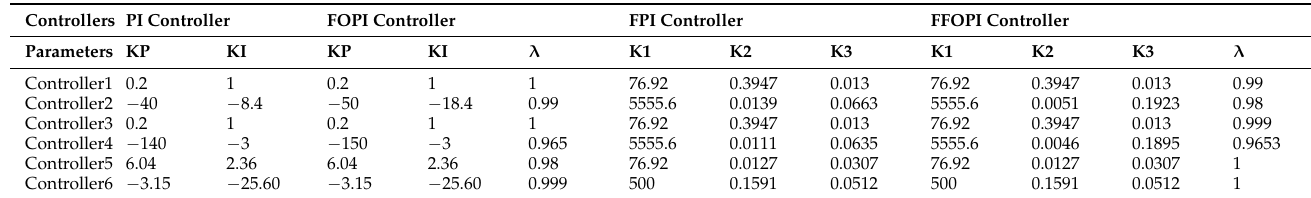
Table 4. Controller gains of microgrid system M 1 for PI, FOPI, FPI, and FFOPI controllers.